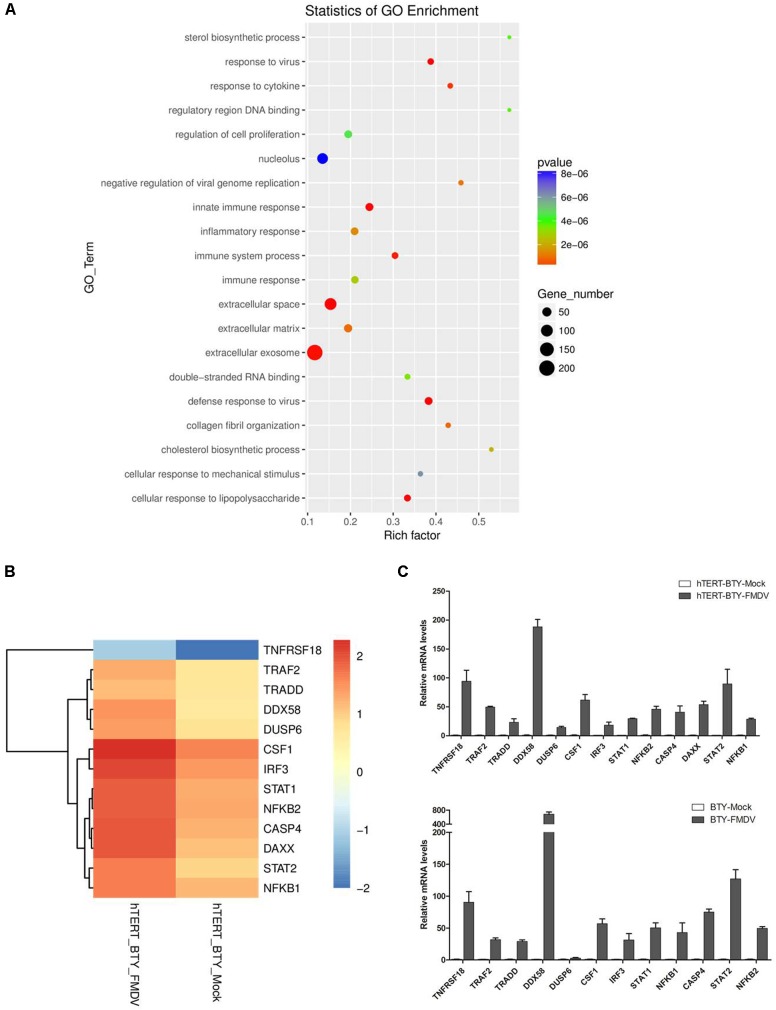
Differentially expressed genes between FMDV-infected and uninfected hTERT-BTY cells. (A) hTERT-BTY cells were infected with O/BY/CHA/2010 at an MOI of 0.01. The transcriptome RNA-seq and scatterplots of significant enrichment items of GO analyses associated with differentially expressed genes were compared between FMDV-infected and uninfected hTERT-BTY cells. The vertical axis is the GO term, and the horizontal axis is a rich factor of GO. The P-value denotes the significance of the GO term (the recommended cutoff of P-value is 0.05). (B) Heatmap of selected differentially expressed genes involved in immune response. (C) Validation of the differentially expressed genes using the qPCR assay in hTERT-BTY cells and BTY cells at passage 3. Experiments were performed in triplicate and repeated three times with similar results. Data are represented as mean ± SD (n = 3).